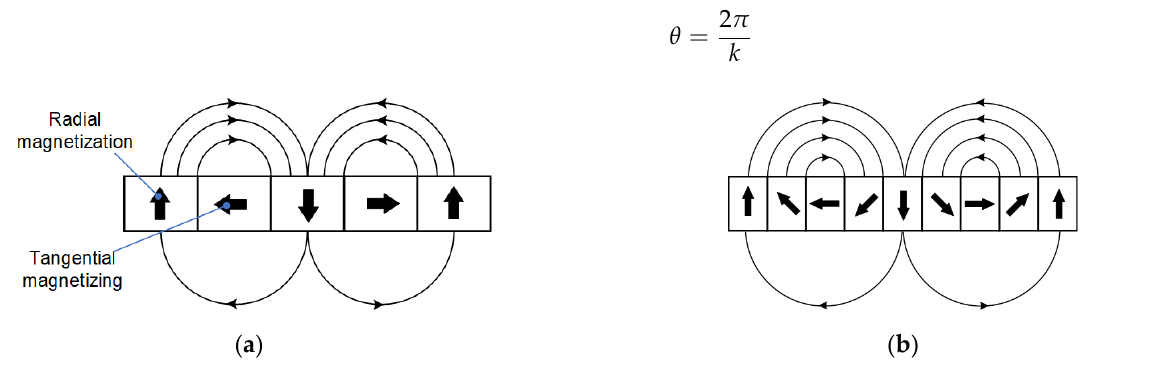
Figure 1. Halbach magnetization diagram: ( a ) Three-section Halbach magnet array; ( b ) Five-section Halbach magnet array.